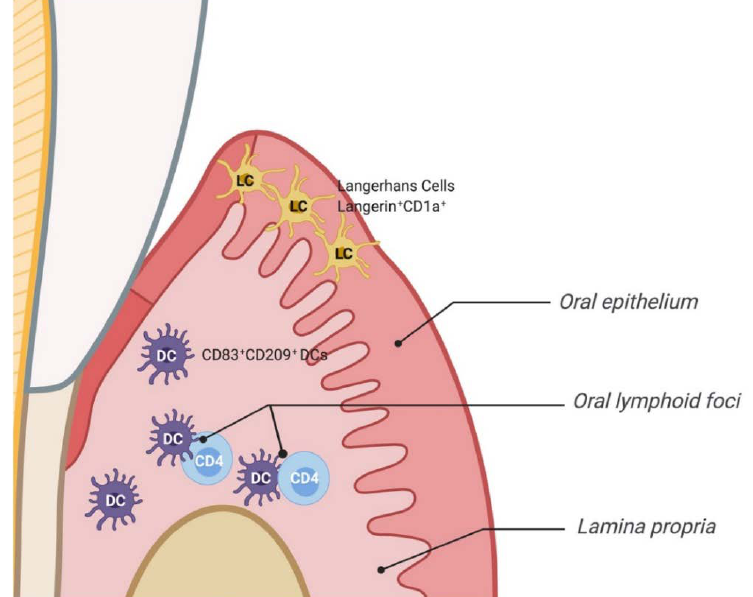
Table 1. DC subsets in periodontal tissues of mice and humans.